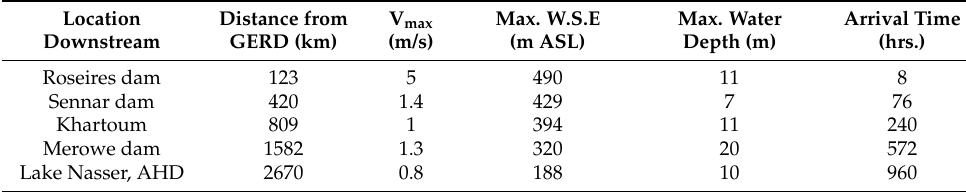
Table 2. Flood parameters downstream of the